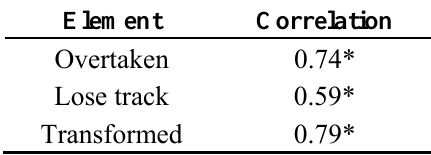
Table 5. Pearson correlations of the three transcendence elements with the “spiritual”